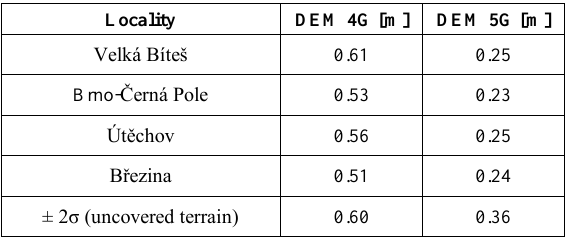
Table 1. Comparison between accuracy of the models in tested locations and the declared accuracy